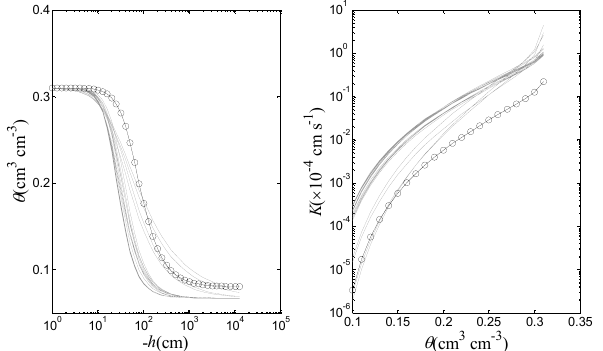
Figure 4. Comparison of the 18 (corresponding to 3 observation depths times 6 initial parameter sets) soil water retention curves θ(h) , and hydraulic conductivity functions, K(θ) , using the con- verging parameters for GA3 (grey solid lines). The solid lines with markers indicate the corresponding functions defined with the pa- rameters found by Romano and Santini (1999). Note that in this study θ r =0.067cm 3 cm − 3 , while Romano and Santini (1999) as- sumed θ r =0.08 cm 3 cm − 3 .